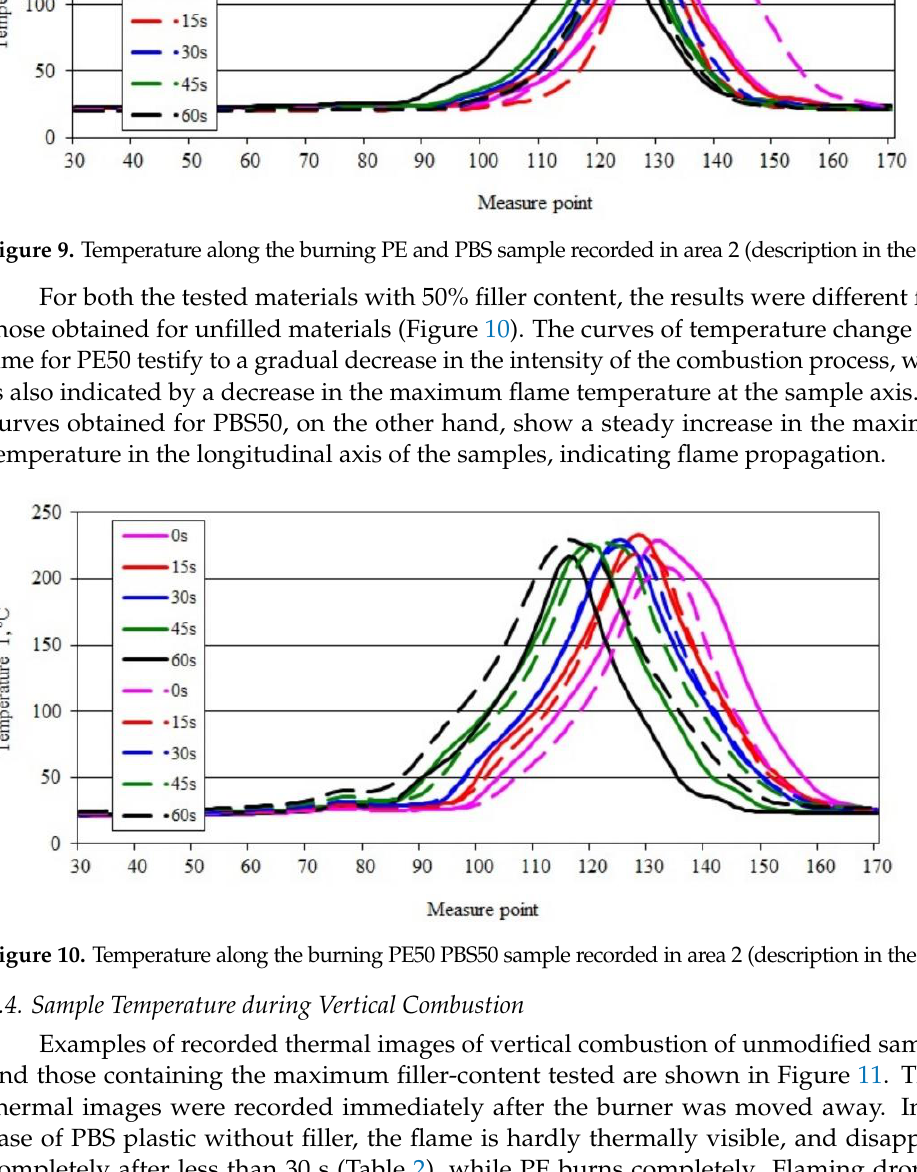
Figure 10. Temperature along the burning PE50 PBS50 sample recorded in area 2 (description in the text).